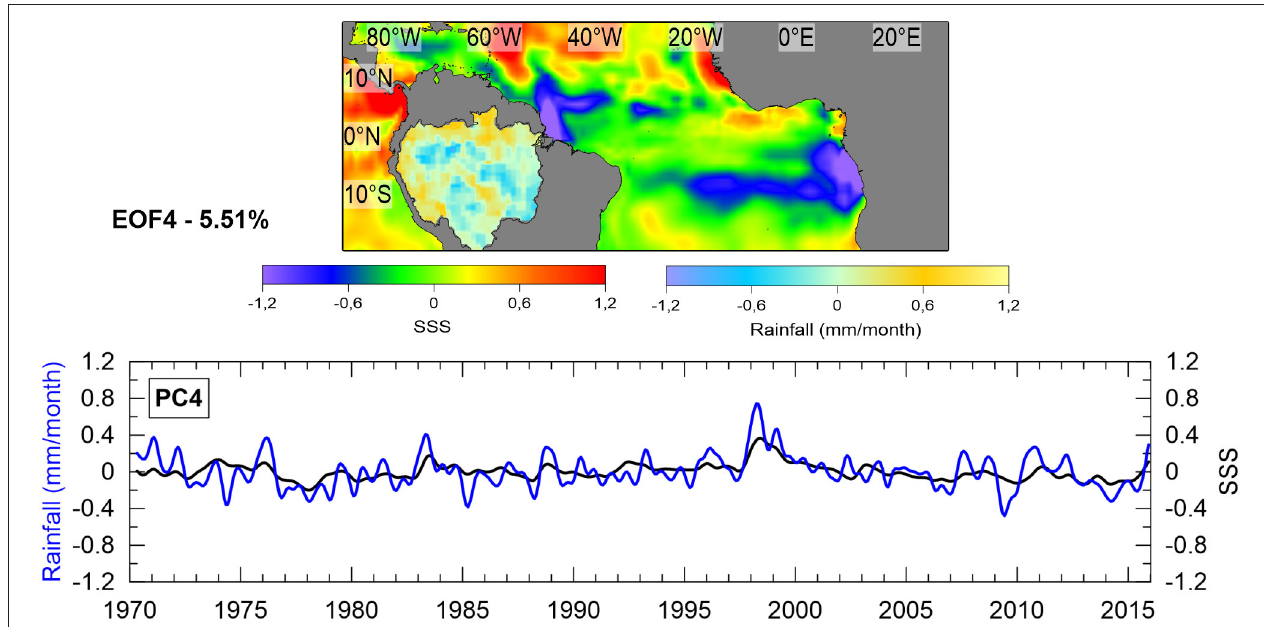
FIGURE 7 | Fourth EOF of 3 month-lagged covariance matrix between rainfall (normalized scale by 10 3 ) and SSS (normalized scale by 10), the Squared Covariance Fraction (SCF) in percentage, and the fourth Principal Component (PC4).